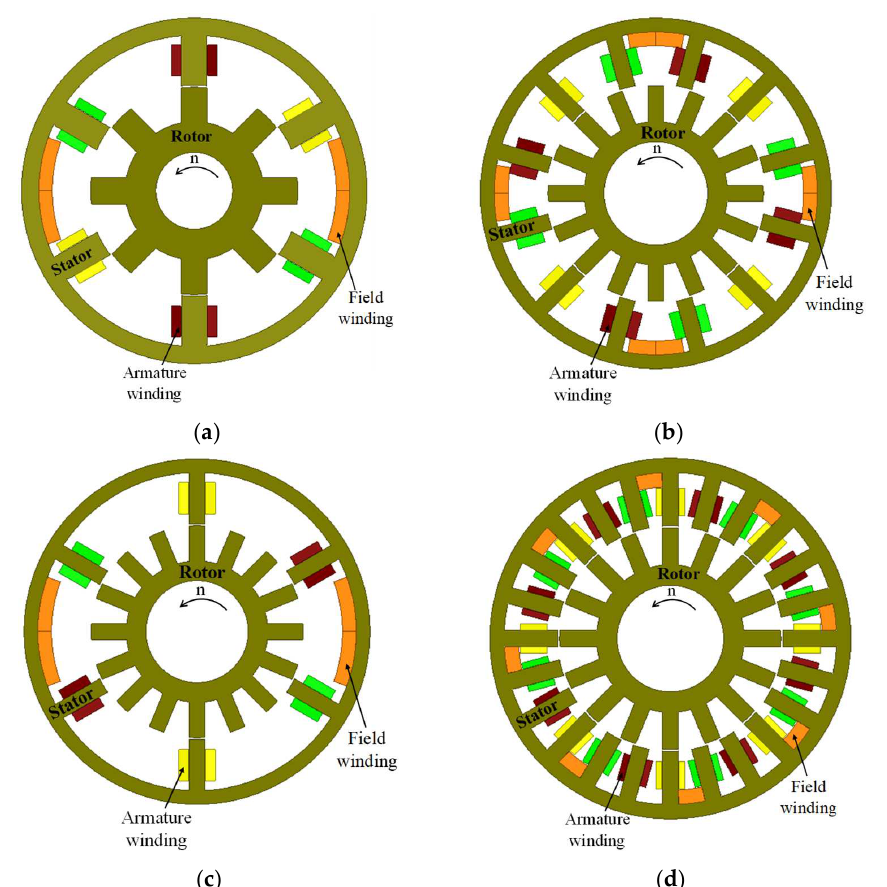
Figure 9. Structure of three-phase DSDCM: ( a ) 6/8-pole [k = 1, N = 2]; ( b ) 12/16-pole [k = 2; N = 2]; ( c ) 6/16-pole [k = 1; N = 4] and ( d ) 24/16-pole [conventional topology, k = 4].